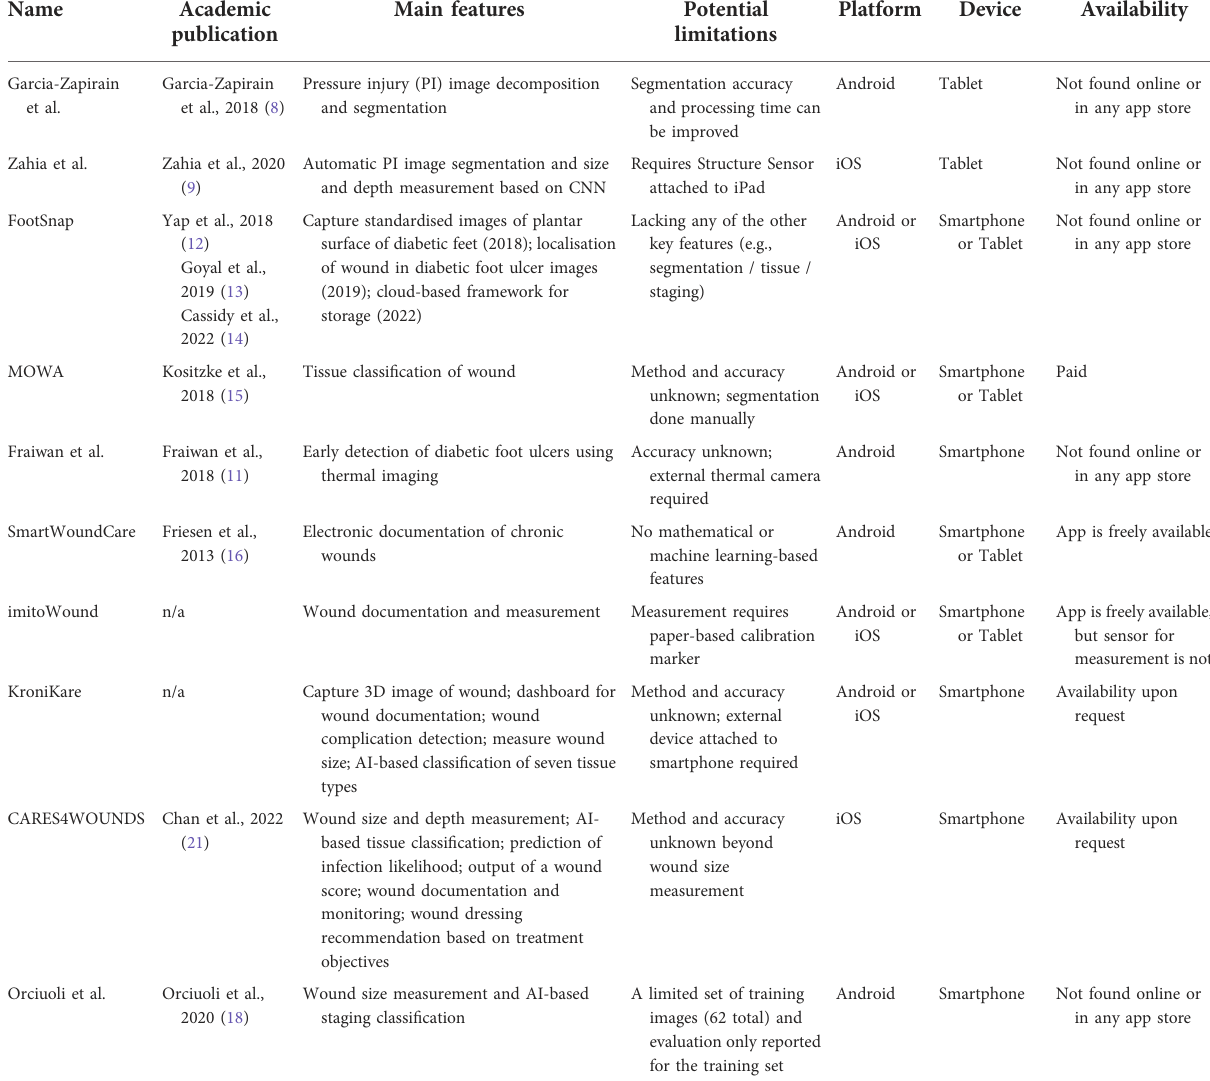
TABLE 1 Summary of the developed wound assessment smartphone or tablet